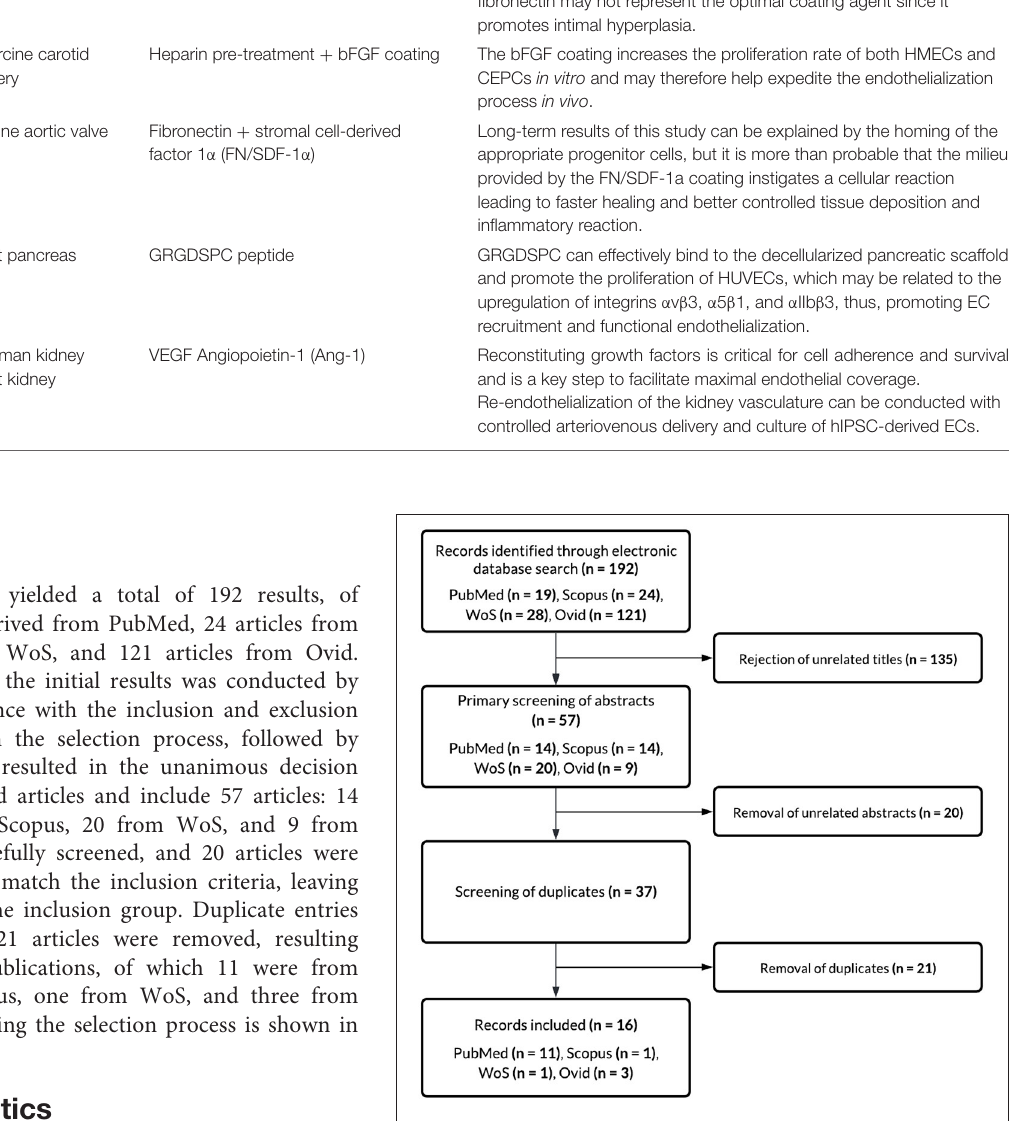
FIGURE 1 | Flow chart depicting selection criteria.